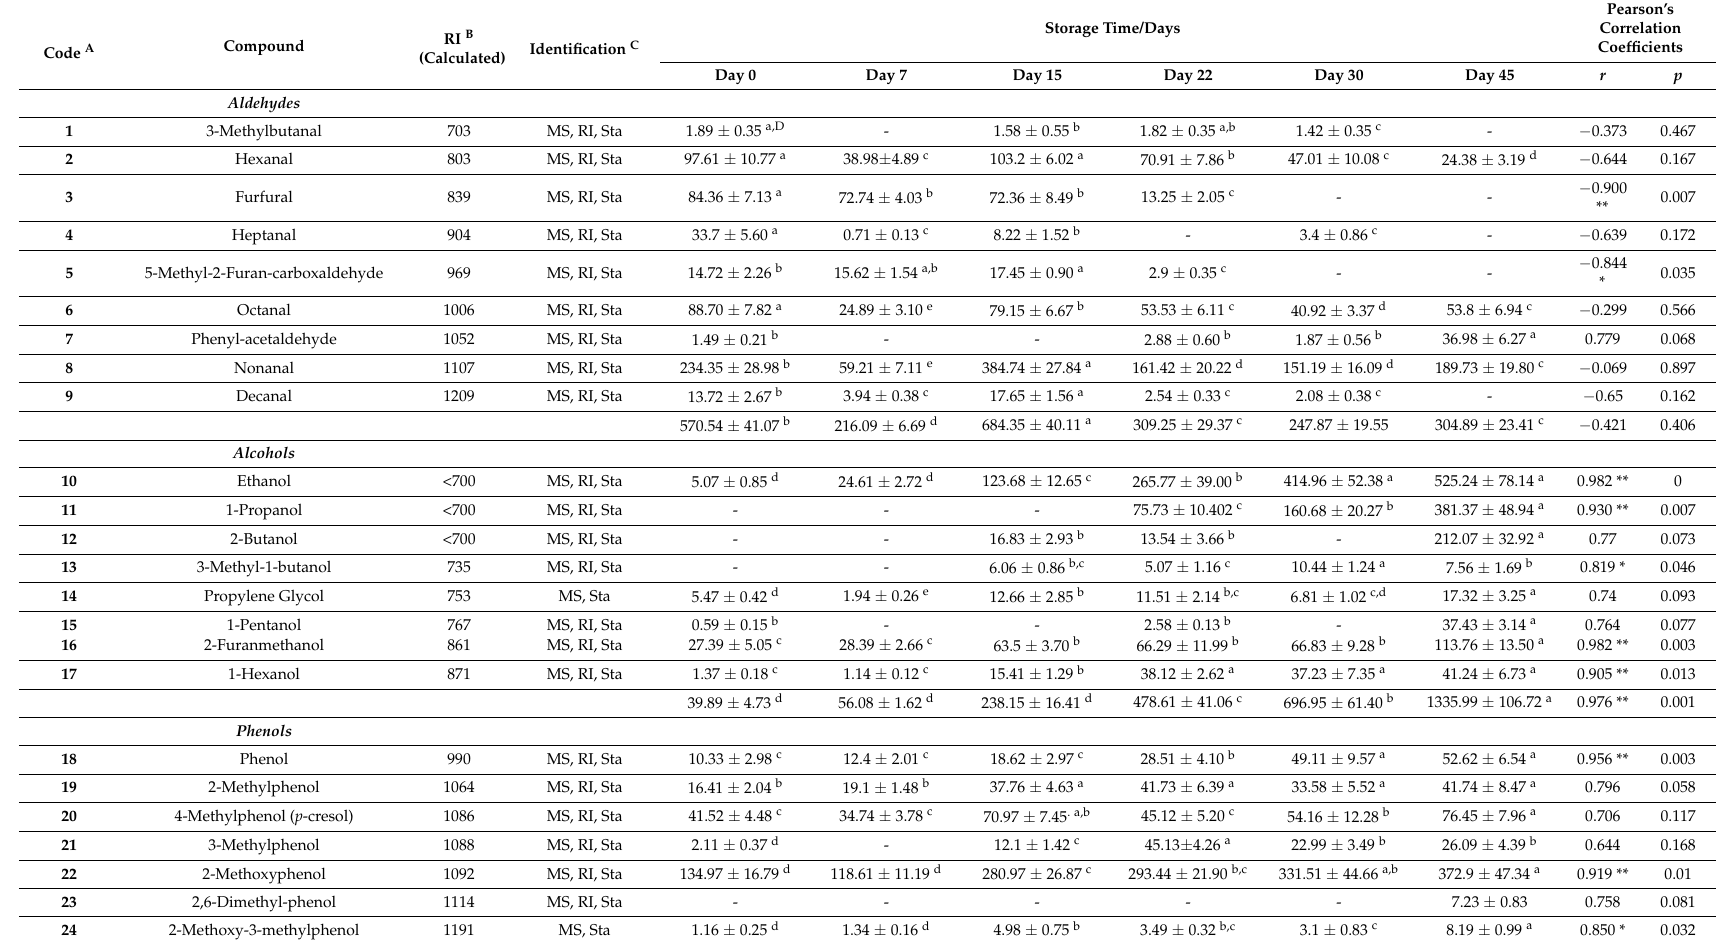
Table 3. Concentrations of VOCs (mg/kg) found for the bacon after 0, 7, 15, 22, 30, and 45 days of refrigerated storage, as measured using